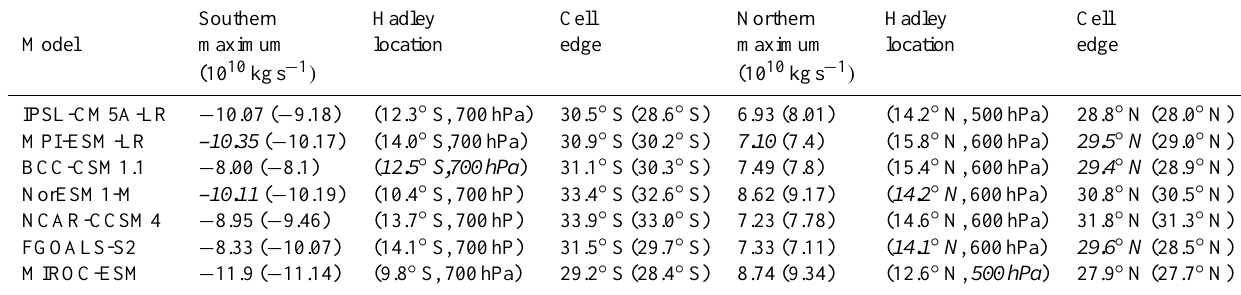
Table 1. Multi-model comparative analysis of Hadley circulation properties (maximum of MSF and corresponding position, Hadley cell boundaries) in the RCP4.5 scenario, and Hadley cell boundaries and maximum MSF from pre-industrial control run (in parentheses).